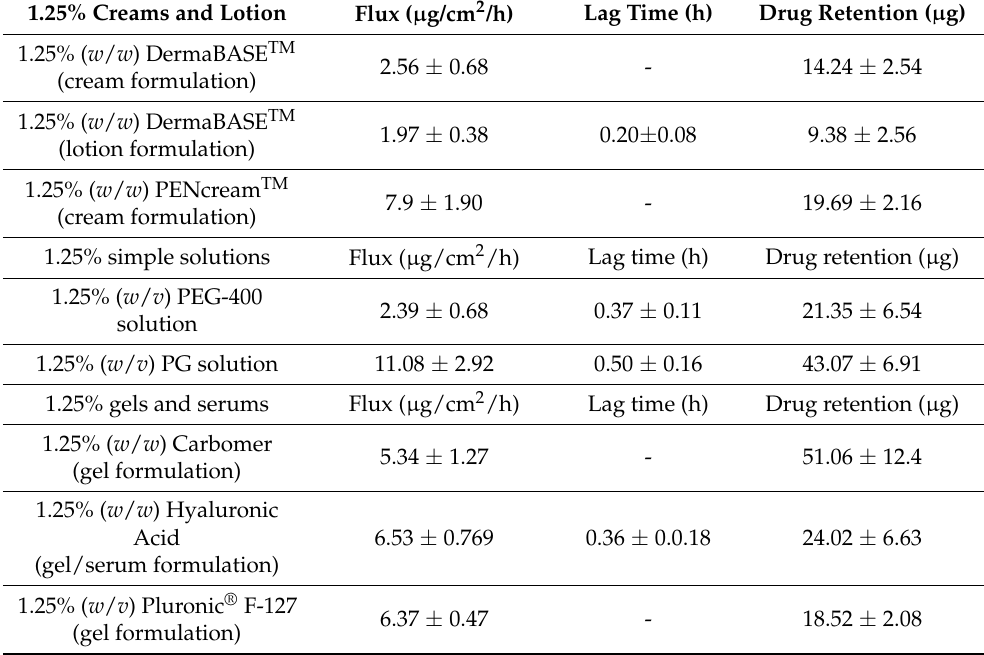
Table 5. In vitro drug membrane parameters of resatorvid topical formulations through EpiDerm TM -D normal human derived epidermal keratinocytes as models for transdermal diffusion ( n = 3, mean ± standard